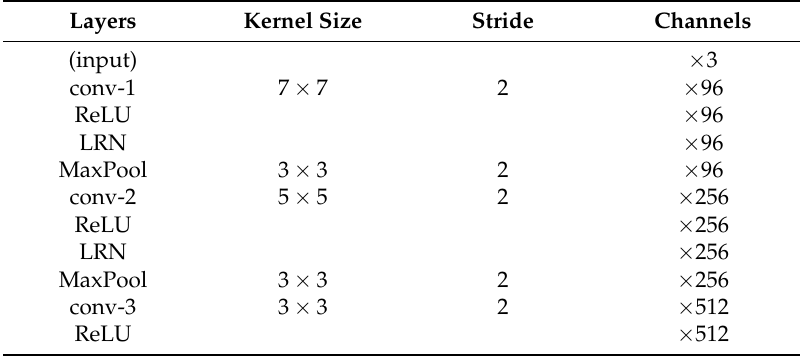
Table 1. The configuration of feature extraction network and architecture details.